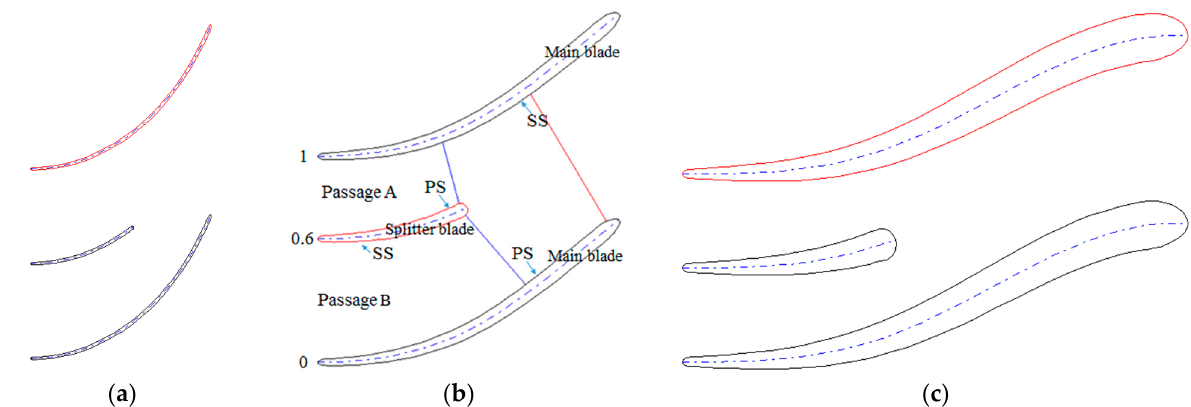
Figure 2. Geometric modeling of impeller: ( a ) Meridian plane of the impeller; ( b ) 3D modeling of turbine and impeller.